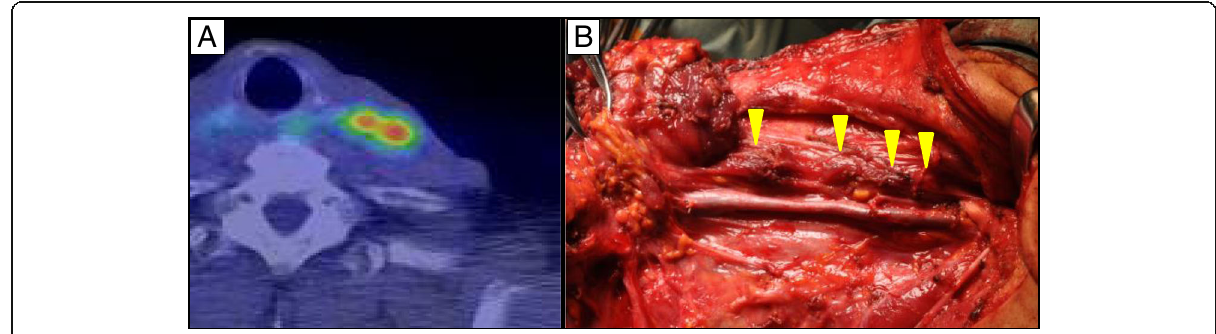
Fig. 5 PET-CT showing left cervical locoregional LN metastases. a Before resection. b Intraoperatively (arrowheads show metastatic LNs)